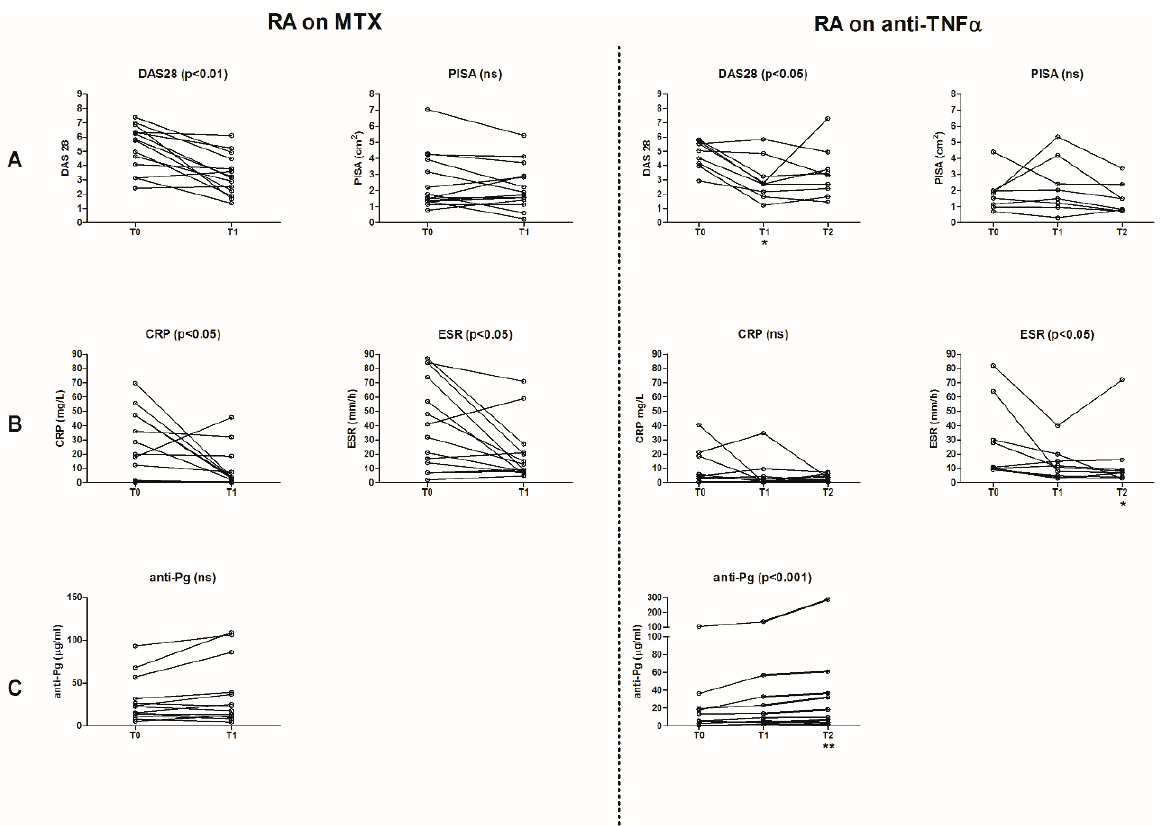
Figure 1. Effect of anti-rheumatic treatment (methotrexate (MTX) and anti-tumor necrosis factor- α (anti-TNF) in addition to MTX) on clinical and laboratory parameters of rheumatoid arthritis (RA) and periodontitis. Each line in the figures represents one patient over time in the study. ( A ) Clinical parameters: RA disease activity (DAS28) and periodontal inflamed surface area (PISA). ( B ) Laboratory parameters: erythrocyte sedimentation rate (ESR) and C-reactive protein (CRP) levels. ( C ) IgG antibody levels against Porphyromonas gingivalis (anti- Pg ). T0: baseline, T1: after 2 months treatment of MTX and after 3 months treatment of anti-TNF in addition to MTX, T2: after 6 months treatment of anti-TNF in addition to MTX, ns: not significant.